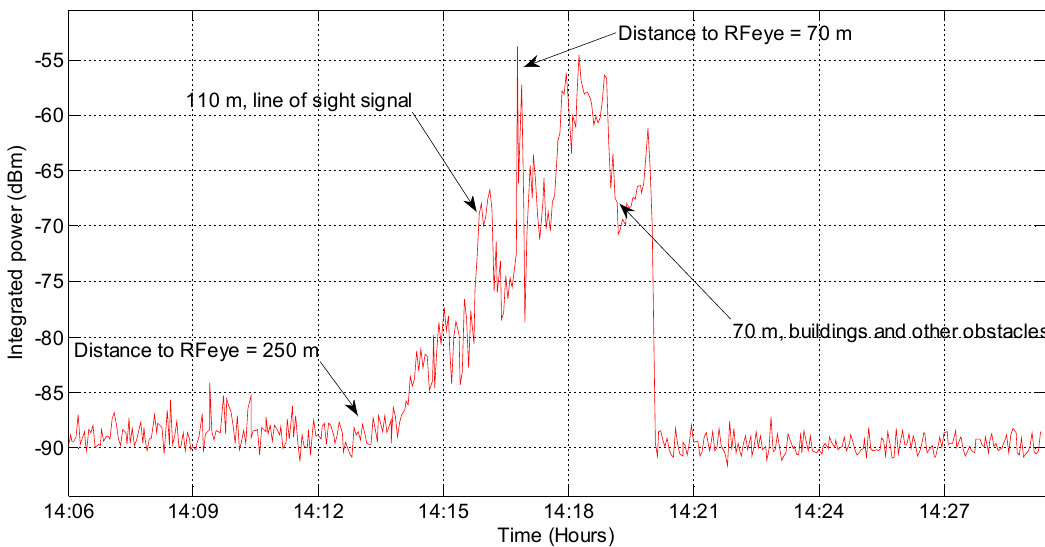
Figure 7 . Integrated power time series for a moving wireless